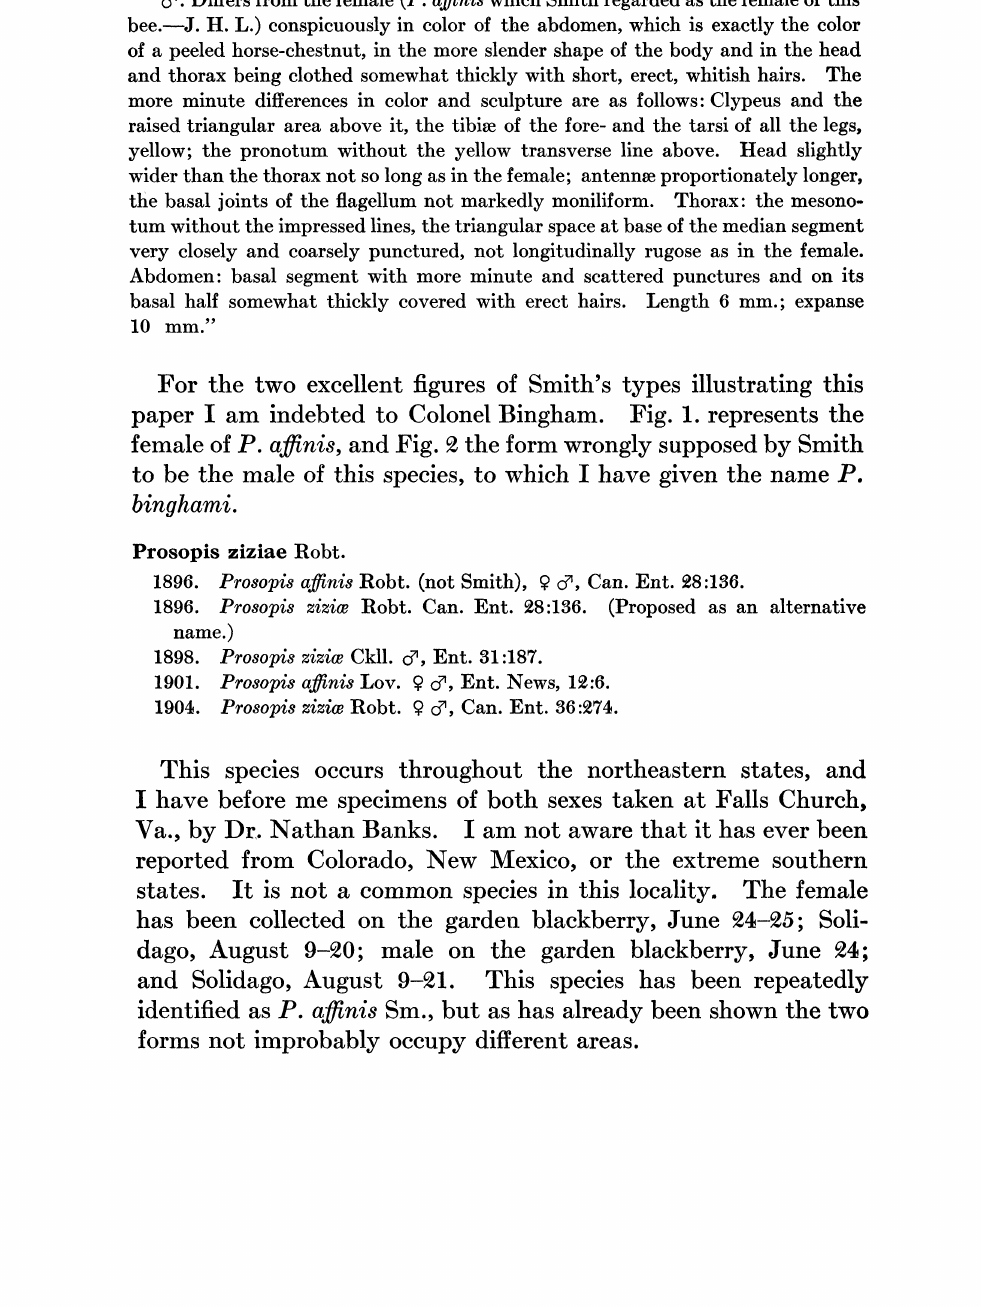
female of P. anis, and